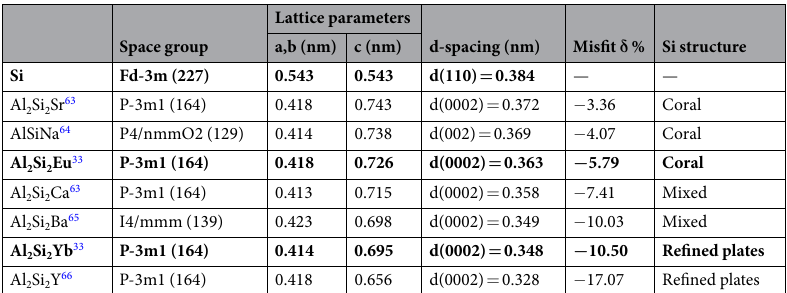
P-3m1 crystal structure with a = b lattice parameters that differ less than 1%, while c differs more than 4% (Table 2). Considering the orientation relationship reported in Fig. 5, the different potency of heterogeneous nucleation for these two phases on Si is evaluated on the basis of the misfit between the Si-surface and the nucle- ating phases. The interplanar spacings d(0002) Al2Si2Eu = 0.363 nm and d(0002) Al2Si2Yb = 0.348 nm can be compared to d(110) Si = 0.384 nm. This comparison shows misfits of 5.79% for Al 2 Si 2 Eu and 10.50% for Al 2 Si 2 Yb towards Si. The higher mismatch of the Yb phase adds strain energy to its nucleation, which makes Al 2 Si 2 Yb clusters less stable than Al 2 Si 2 Eu clusters on Si facets. This calculation can be applied to similar ternary phases present in the Al-Si alloys with addition of other elements. Table 2 shows how the three systems forming Si corals (addition of Na, Sr or Eu), have ternary phases with a misfit smaller than 6%. Ca and Ba, elements which can induce the formation of fibrous Si similar to the coral structure when higher amounts of these elements are added 22,23 , have a higher misfit, while Yb and Y ternary phases show the highest misfits and also the lowest potency as modifiers 22,31 .